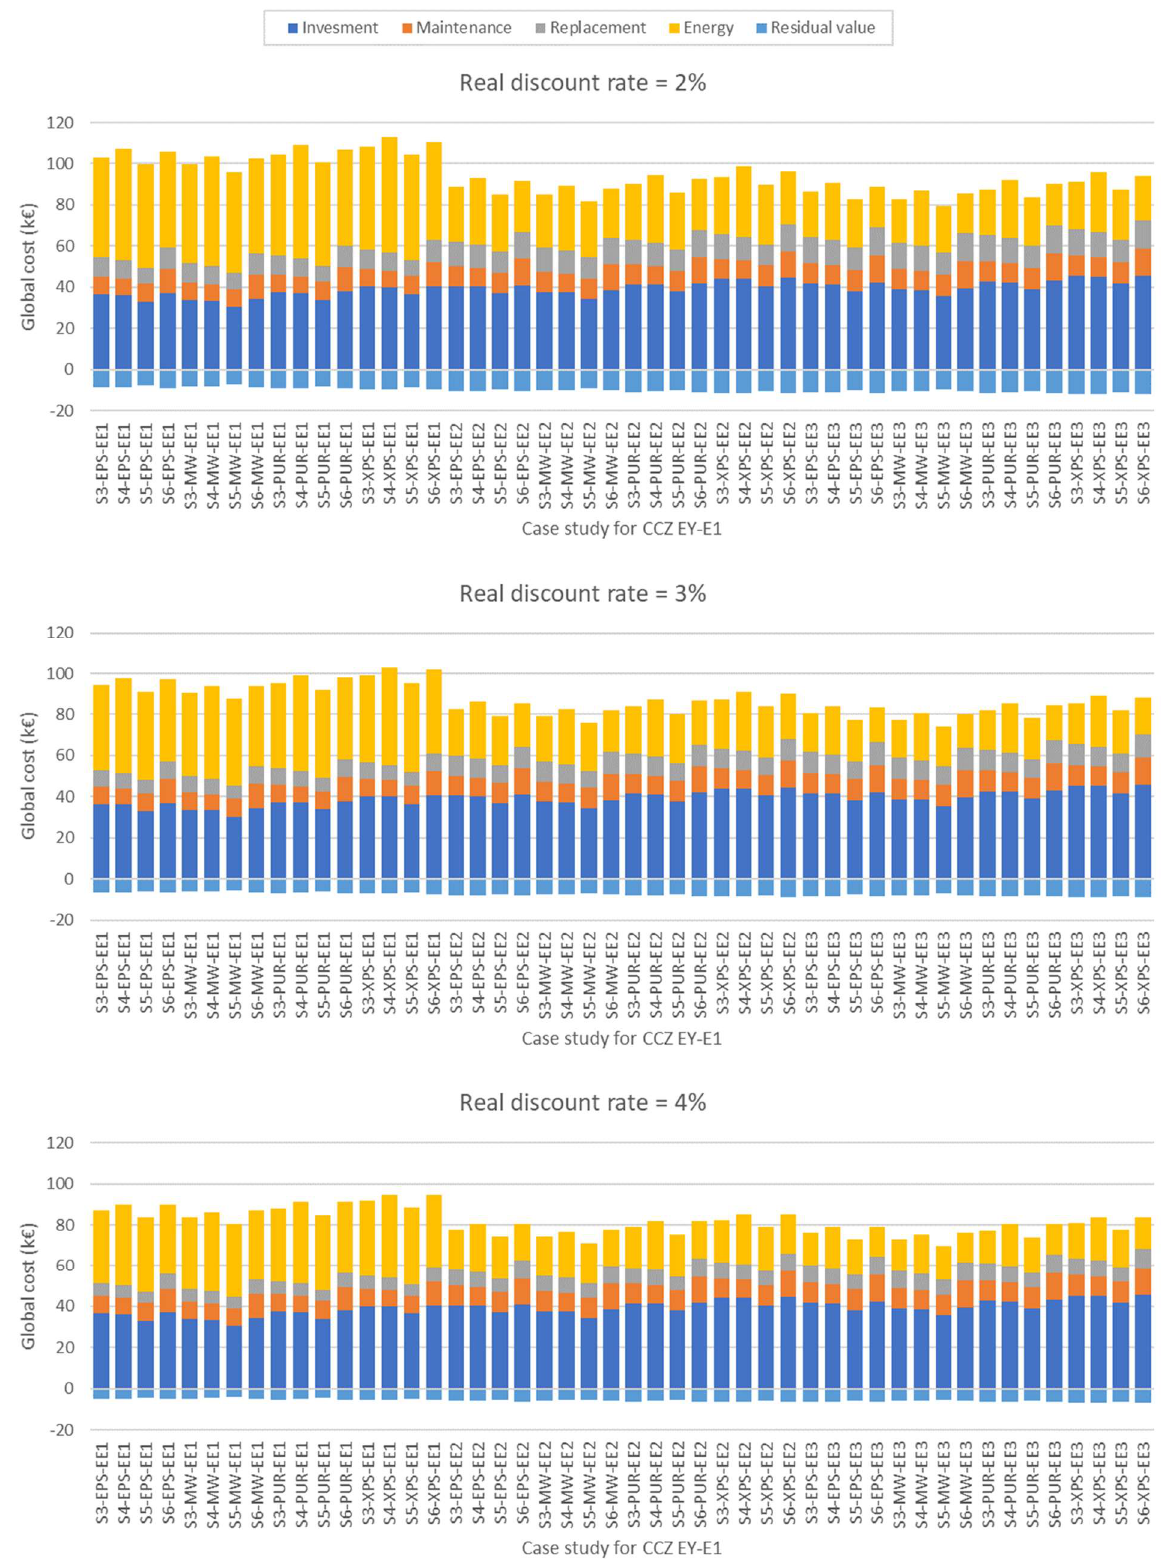
Figure 8. Global cost breakdown by the different costs and residual value, in EUR 1000, for each energy renovation solution in CCZ EY-E1 by real discount rate.